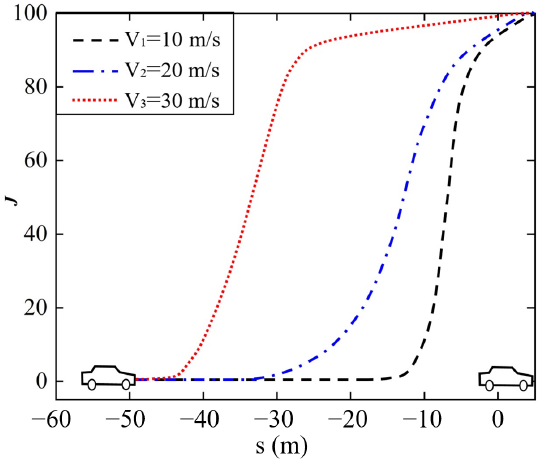
Figure 8. Collision risk